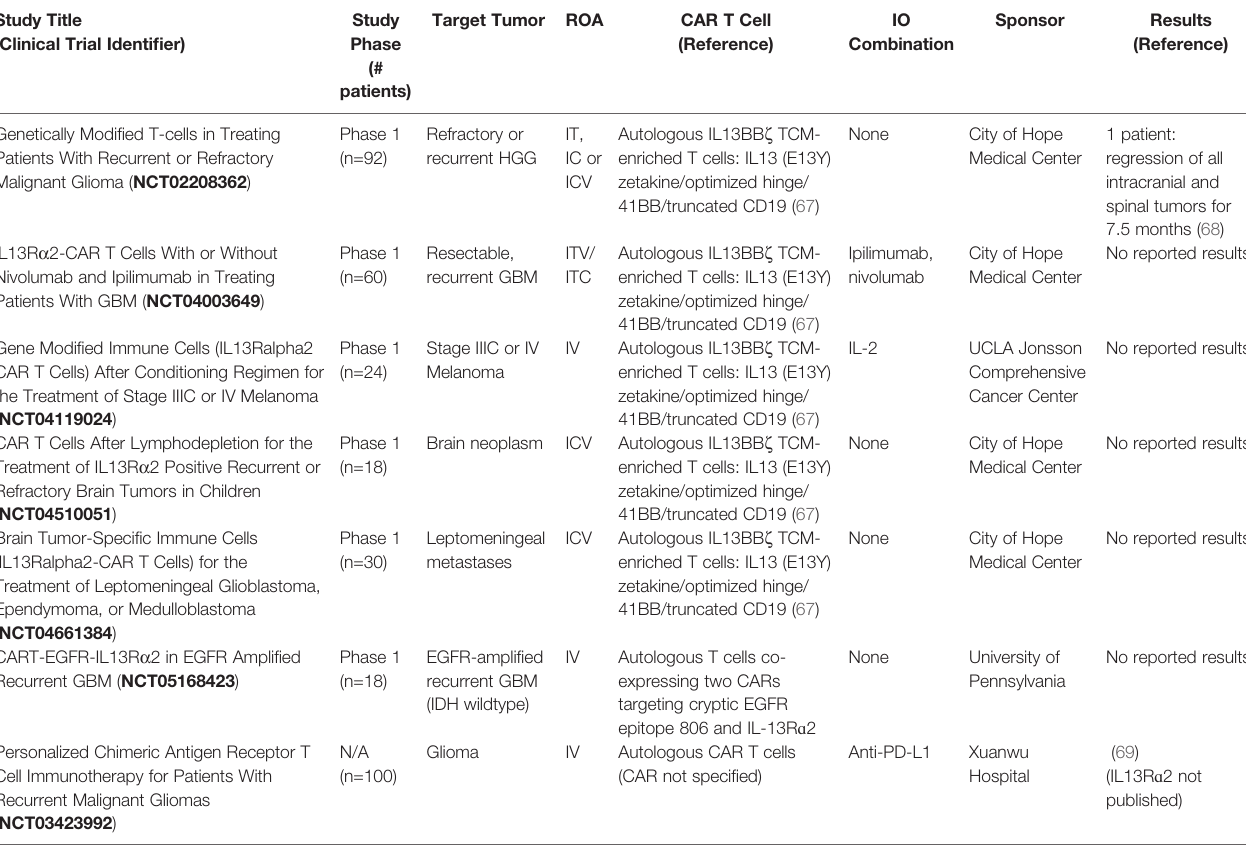
TABLE 1 | Ongoing IL-13R a 2-targeted CAR T cell therapy clinical trials (from clinicaltrials.gov